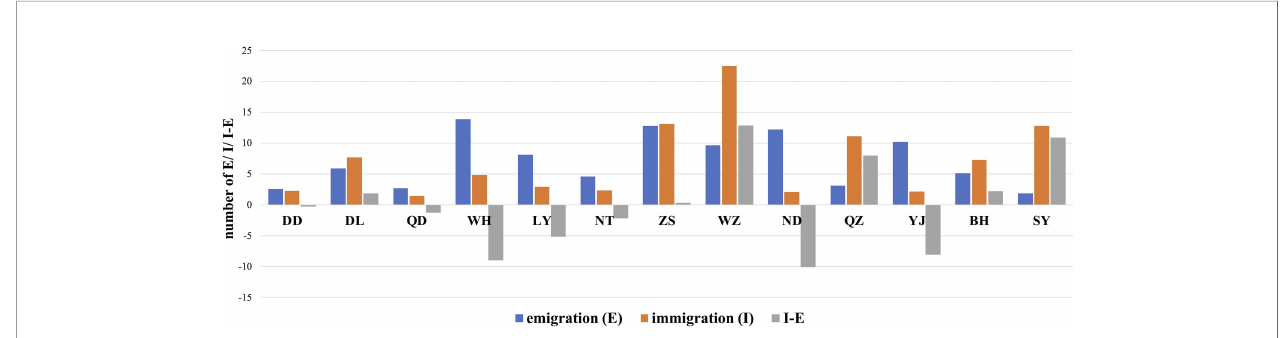
FIGURE 5 | The bar graphs indicated the total emigrations and immigrations, and the values of emigrations minus immigrations in each population of Trichiurus japonicus . See Table 1 and Figure 1 for the population names and